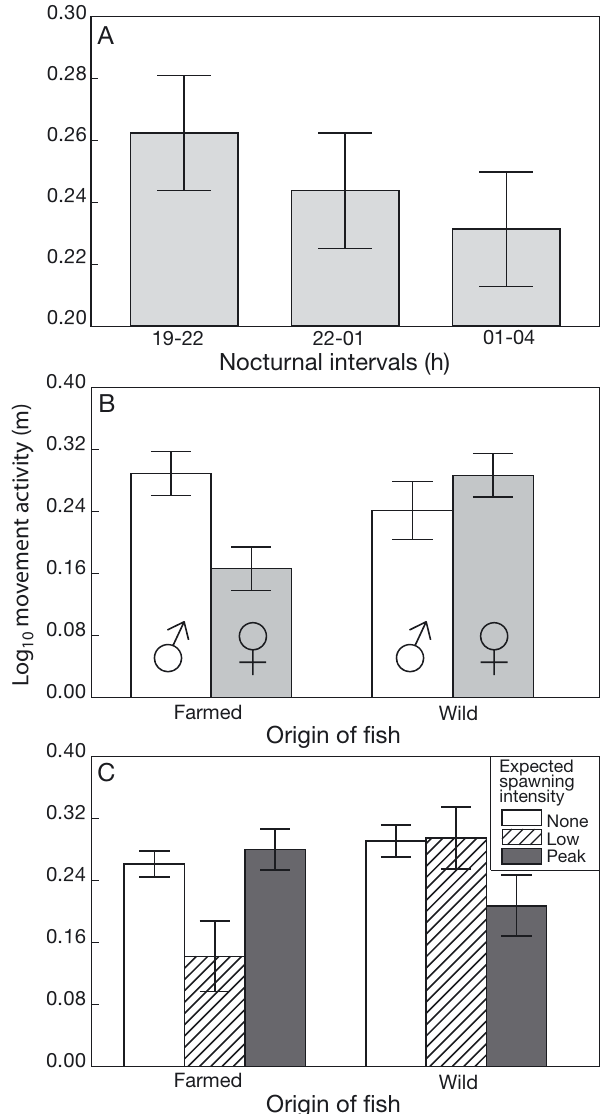
Fig. 3. Burbot movement activity across (A) night intervals, (B) fish origin and sex and (C) fish origin and spawning intensity. Values are adjusted means (±SE) from log 10 - transformed movement activity